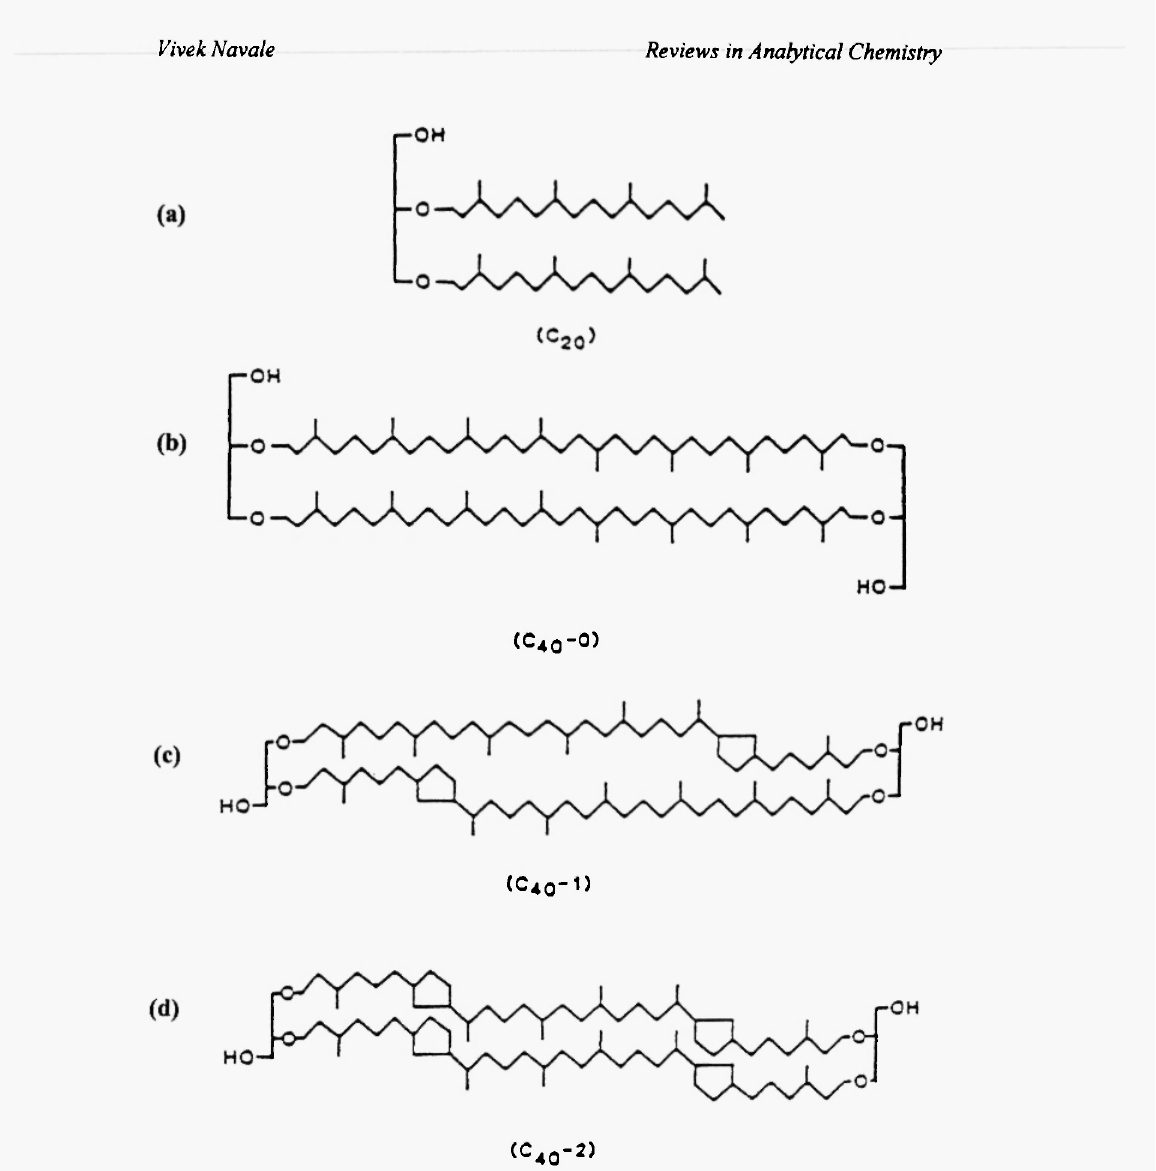
Fig. 5: Schematic representation of archaeal glycerol ether lipids. (5a) shows two identical phytanyl (-C 2 oH 4 ,) side chains bound to the glycerol molecule by the ether bonds, (5b) shows the two (-C 40 H 8 I) side chains, diglycerol and tetra ether components, (5c) shows the presence of two cyclopentanyl rings in each chain of the structure shown in 5b, and (5d) indicates the four cyclopentanyl rings, (reprinted from Pauly & Van Vleet, 1986, ref /78/ with kind permission from Elsevier